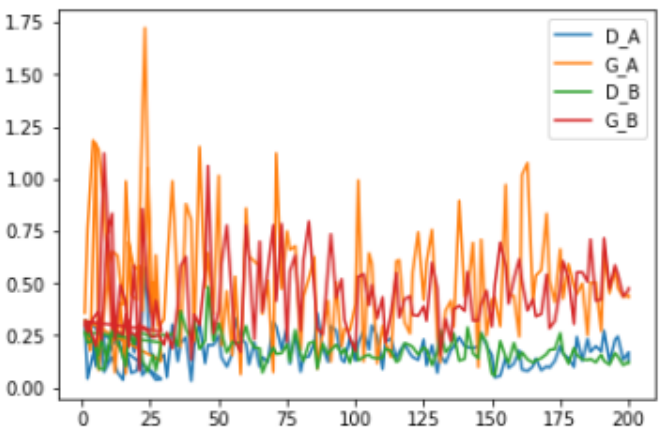
Figure 10 . The training loss of POCS-CycleGAN trained on the brain dataset with the radial trajec- tory, and the sampling rate was 10%. The four curves demonstrate the loss for 𝐷 (cid:3052)